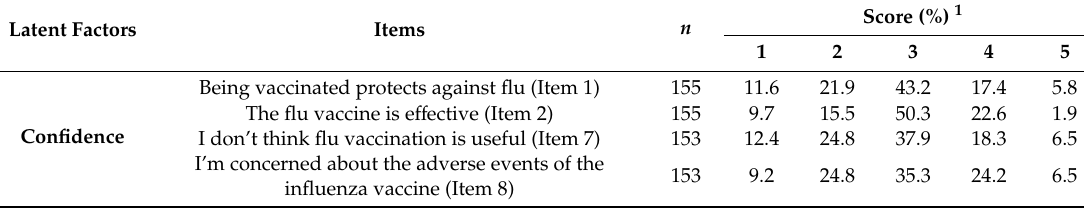
Table 2. Frequency distribution (%) of items representing the 3Cs of the